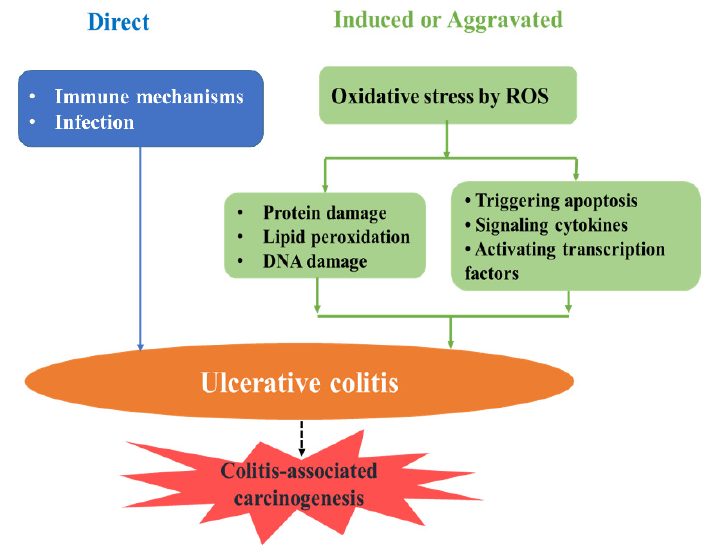
Figure 1. Hypothetic mechanisms involved in oxidative stress-induced ulcerative colitis, which may lead to colitis-associated carcinogenesis. Oxidative stress develops as the inflammatory cells, neu-trophils, and macrophages produce large amounts of ROS, which are associated with the pathogenesis of chronic inflammatory bowel disease.